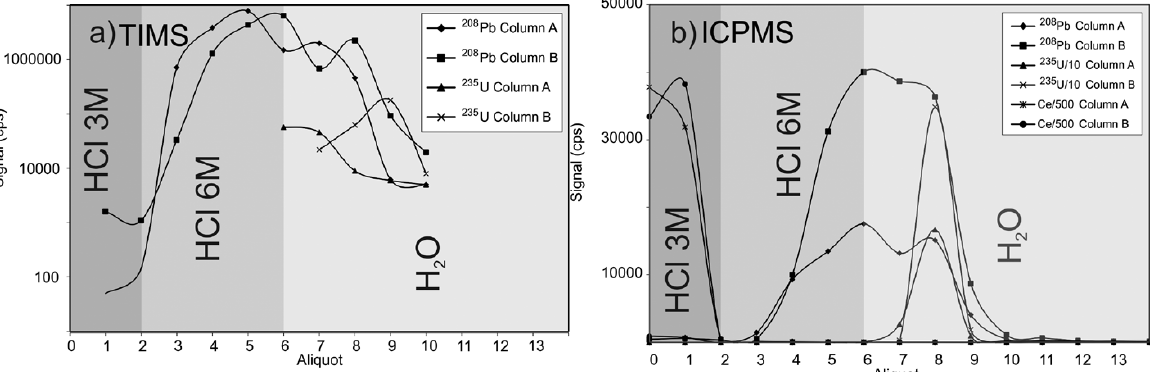
Figure 2 - Diagrams of signal intensity (cps) versus volume of solution through resin column, measured by using TIMS (a) and ICPMS (b) , used in the chromatographic separation of Pb and